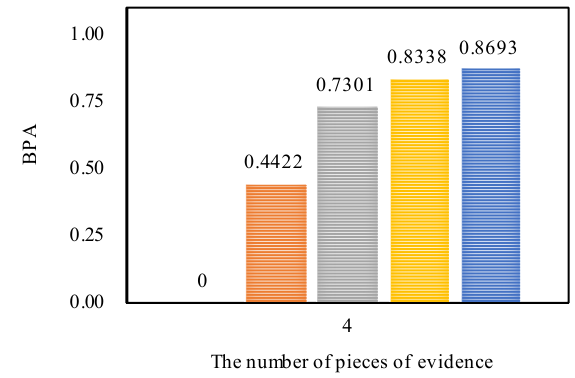
Figure 4. The comparisons of target Se ’s BPA in terms of different